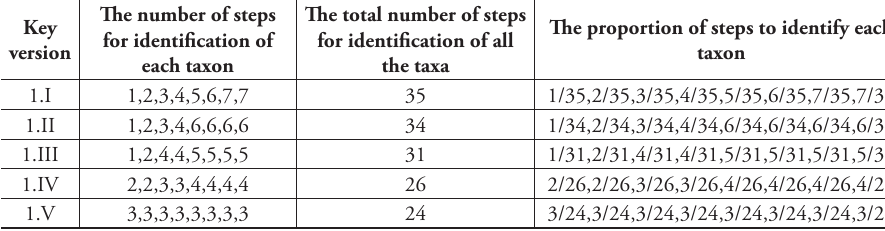
for the keys in Figure 1. Dicho